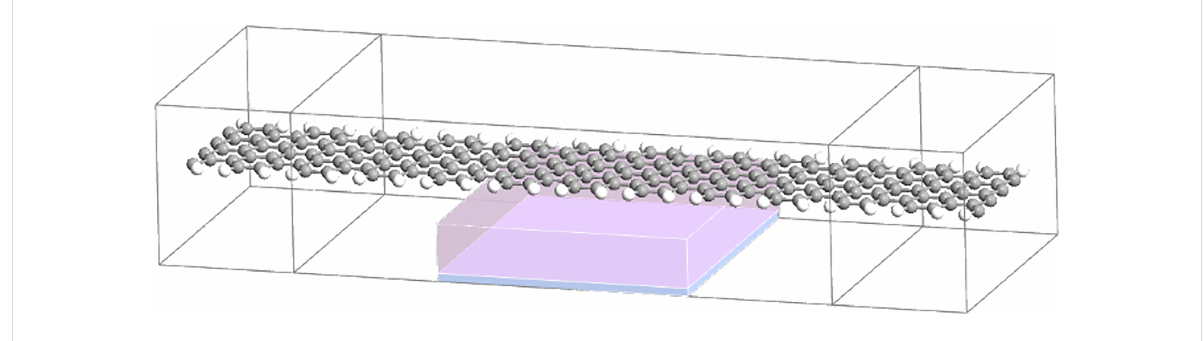
Figure 3: Illustration of the gas sensor with the 8-AGNR FET platform. The structure consists of the left and right electrode and the channel region in the middle with a metal back gate.